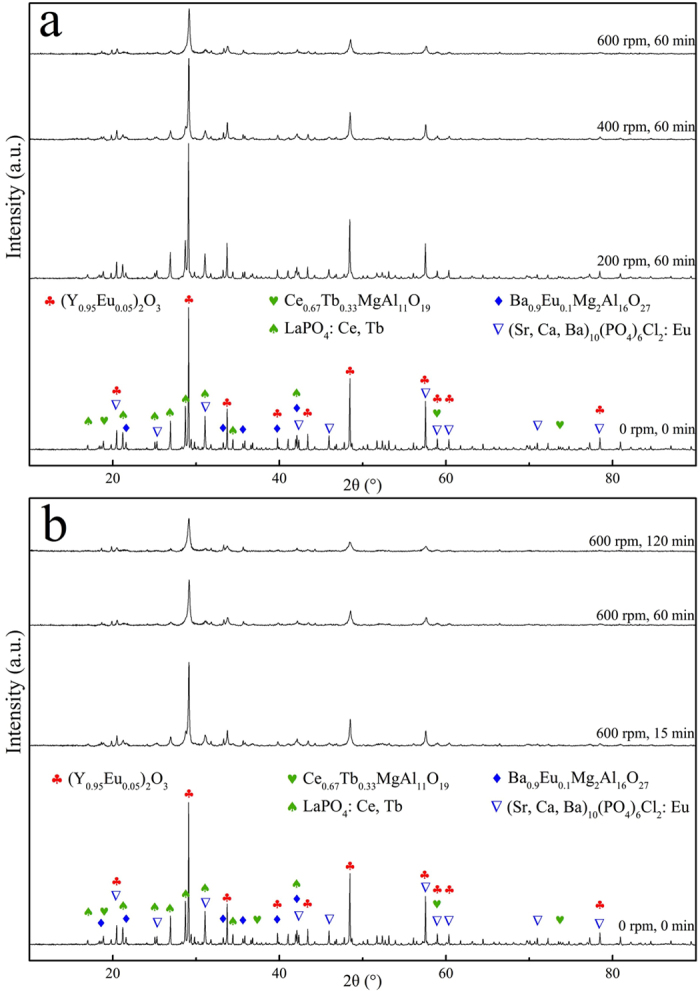
XRD patterns of inactivated and activated waste phosphors.